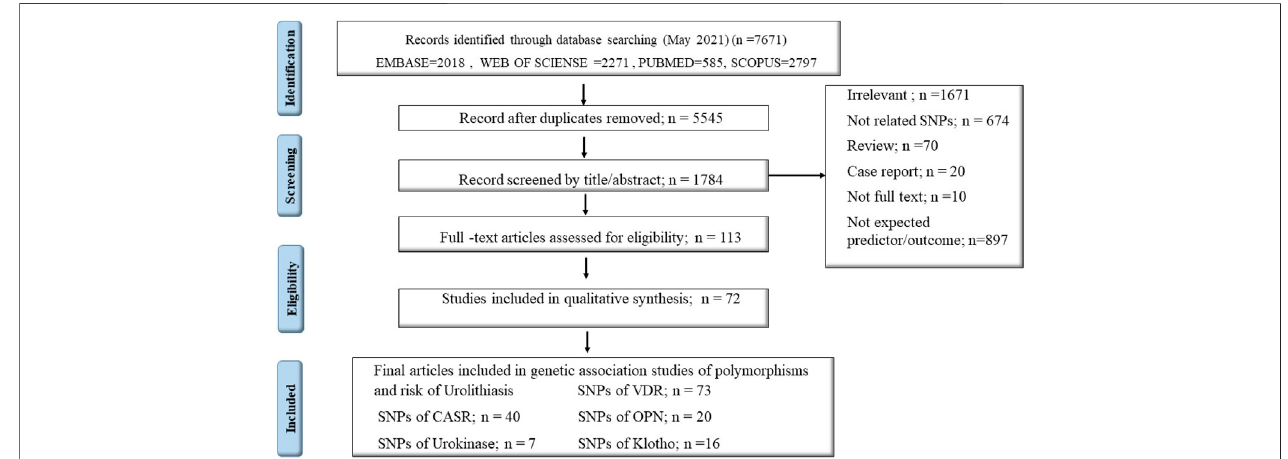
FIGURE 1 | PRISMA fl ow